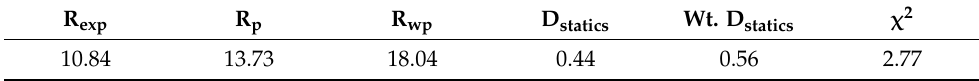
Figure 4. Rietveld refined XRD pattern of β-SnWO 4 nanostructures. Table 1. Data obtained through Rietveld refinement of the diffraction data of β -SnWO